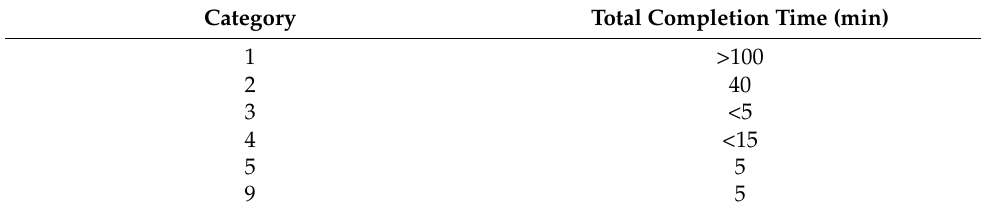
Table 5. Total completion time per category for the right